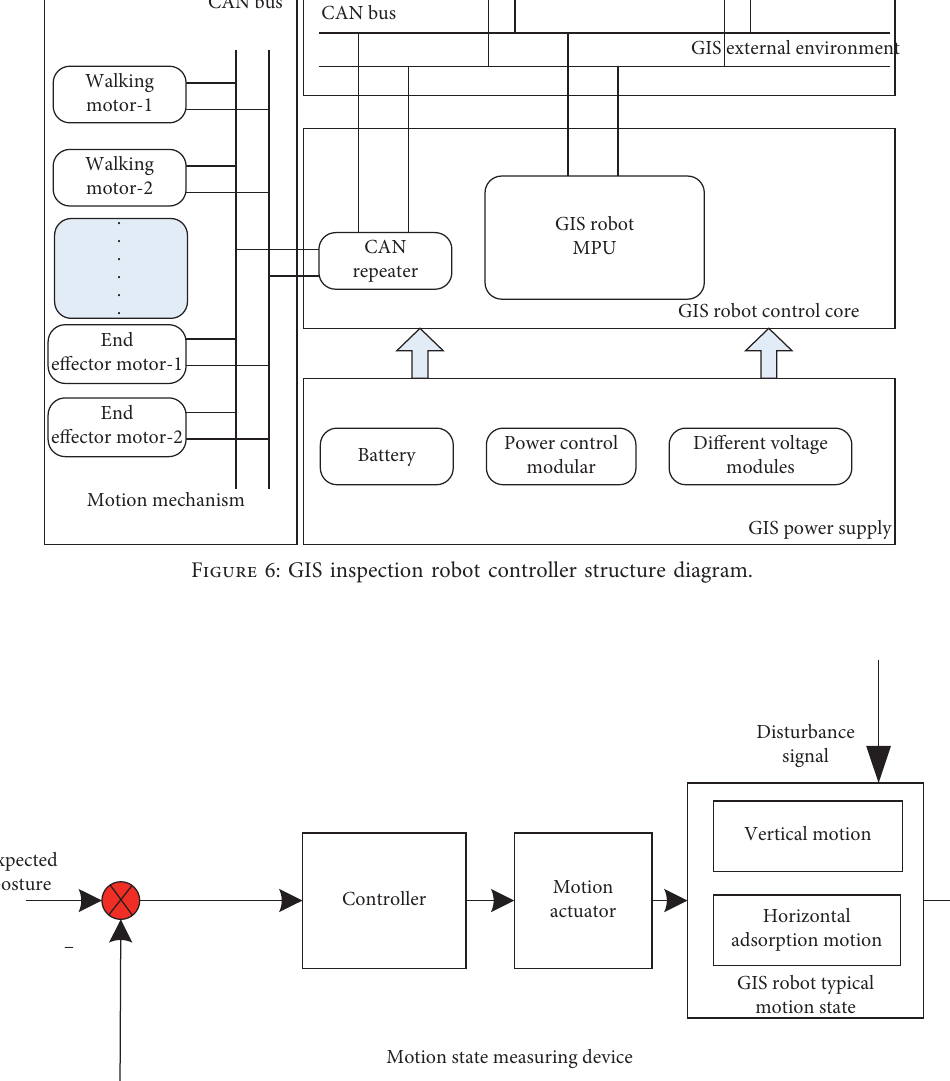
Figure 7: GIS inspection robot control system structure